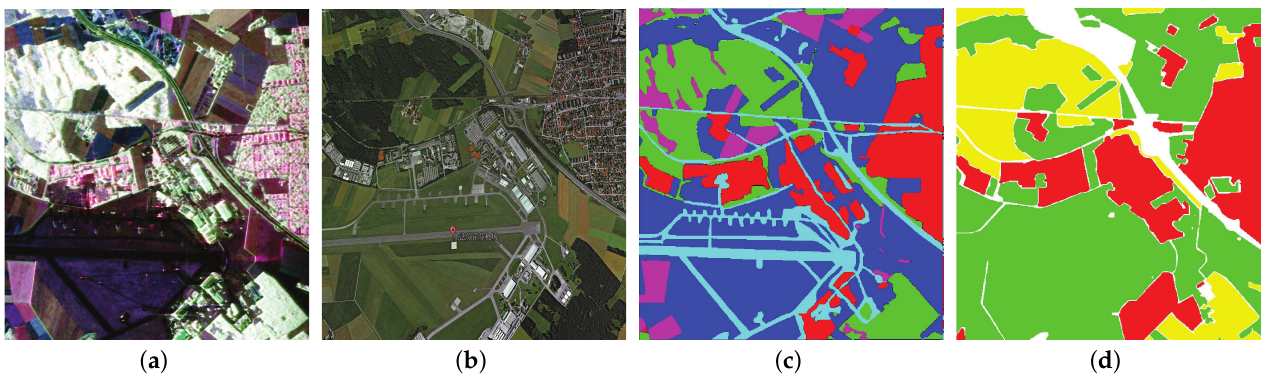
Figure 5. Oberpfaffenhofen data. ( a ) PauliRGB image. ( b ) Google Earth image. ( c ) Ground truth based on [30]. ( d ) Ground truth based on